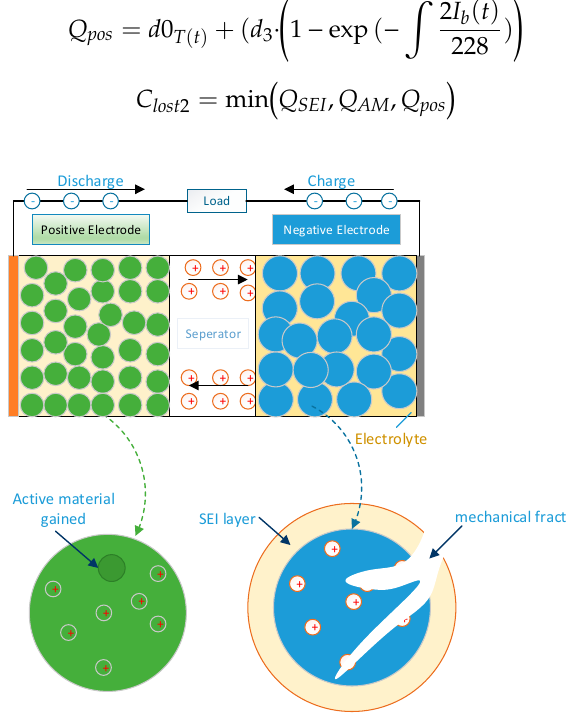
Figure 5. Degradation mechanisms considered in the semi-empirical model.